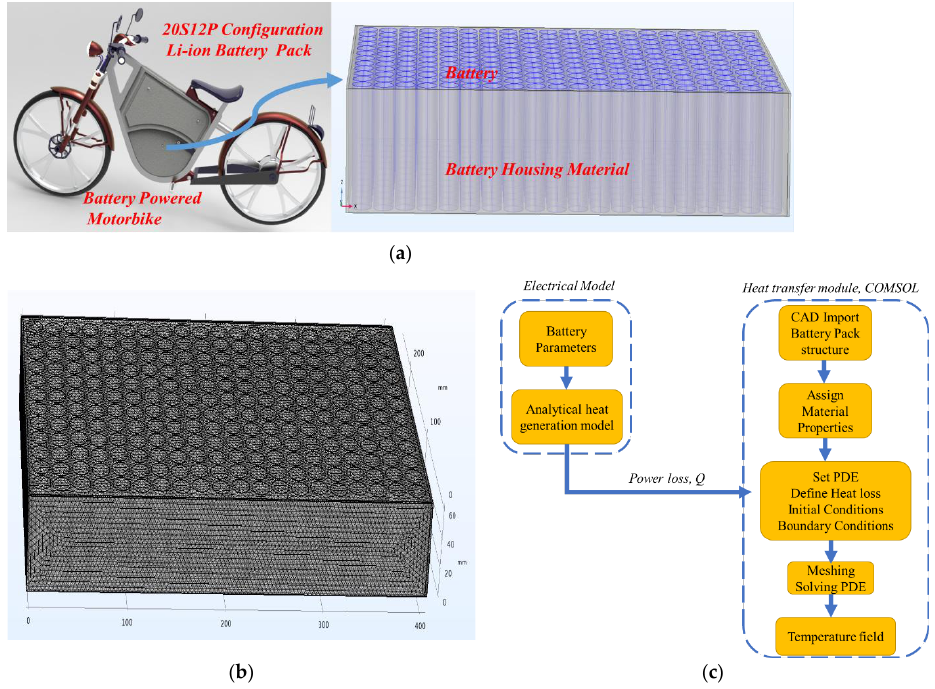
Figure 1. ( a ) Typical configuration of 2.8 kW electric motorbike containing 72 V 43 Ah battery pack and ( b ) meshed model of the studied battery pack and ( c ) thermal model set